Question: Compose a caption that would accompany this figure in a paper.
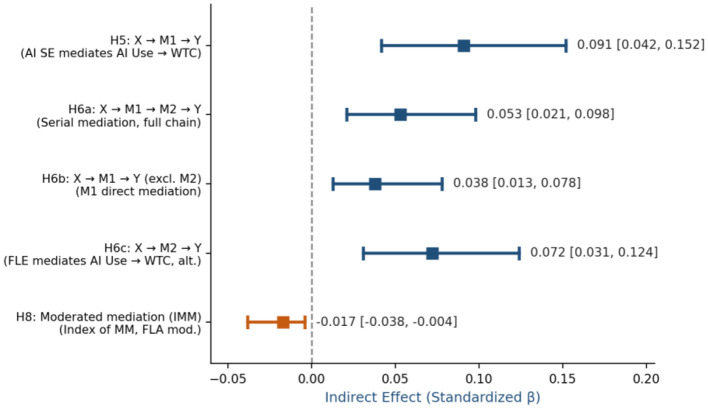
Answer: Forest plot of bootstrapped indirect and moderated mediation effects with 95% confidence intervals (10,000 replications). IMM, index of moderated mediation. Bars not crossing zero indicate significant effects. N = 420.